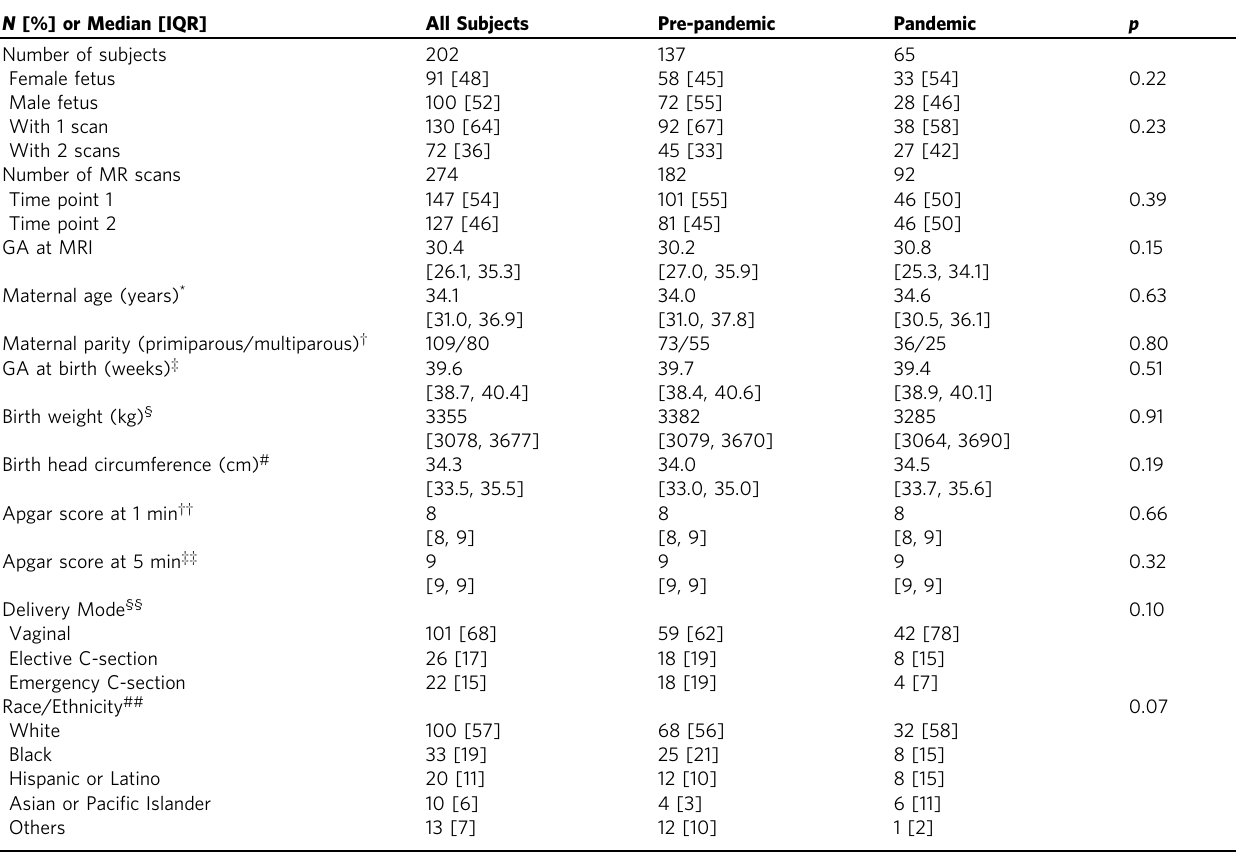
Table 1 Demographics of 202 pregnant women who underwent 274 prenatal MRI studies. N [%] or Median